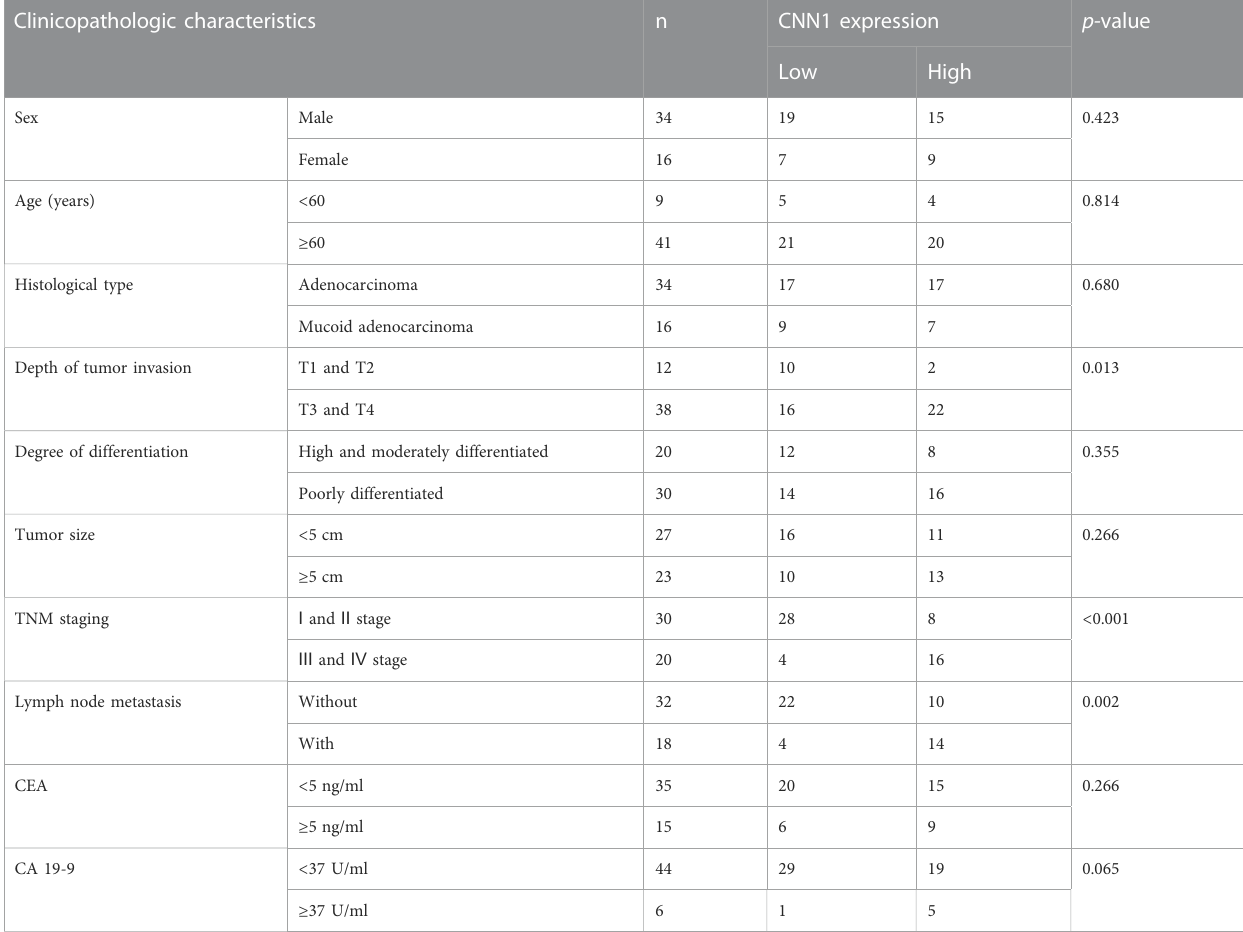
TABLE 1 Correlation between CNN1 and clinicopathologic characteristics. Clinicopathologic